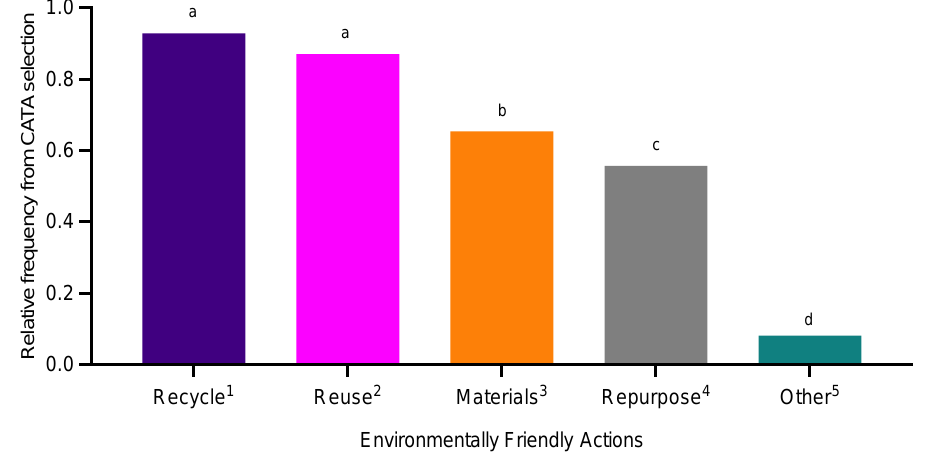
Figure 3. Consumers (n = 393; 12 consumers selected ‘no’ to recycling; therefore, were not asked this question) common environmentally friendly actions ( 1 recycle items; 2 reuse items; 3 buy items made